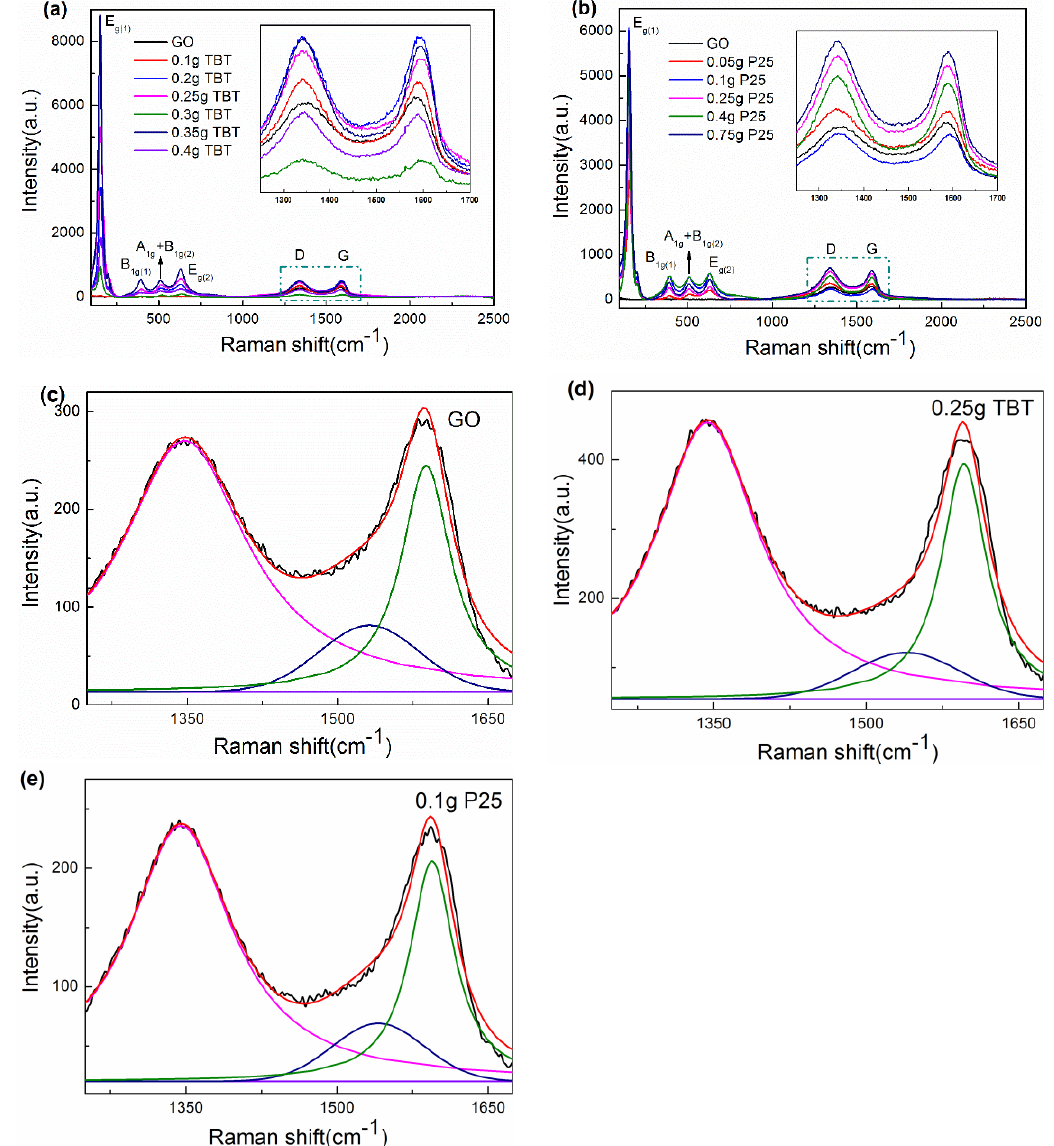
Figure 5. Raman spectra of GO, 0.25 g TBT sample ( a ) and 0.1 g P25 sample ( b ). The inset shows the D-band and G-band partial Raman spectra ranging from 1250 to 1700 cm − 1 . Raman spectra of GO ( c ), 0.25 g TBT sample ( d ), and 0.1 g P25 sample ( e ) with the corresponding curve fitted bands.